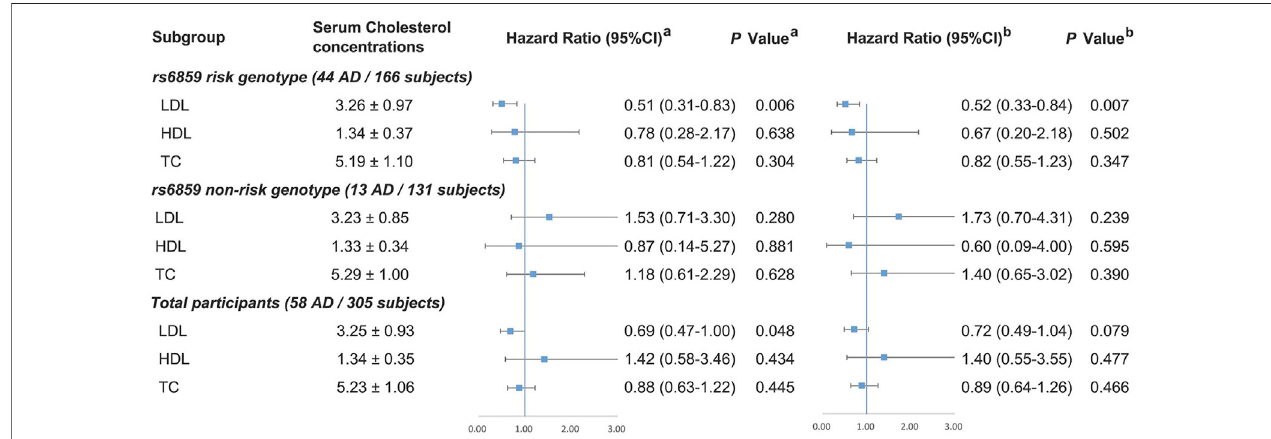
FIGURE 2 | Association between cholesterol and MCI-AD progression among total participants and in subgroups strati fi ed by PVRL2 rs6859 genotypes. PVRL2 rs6859 AG/AA was de fi ned as risk genotype and GG was non-risk genotype. a Model 1 was adjusted for age, gender, APOE ε 4 status, and education years. b Model 2 was additionally adjusted for vascular risk factors (body mass index, diabetes mellitus, hypertension, coronary heart disease, stroke, smoking, and drinking) and lipid- lowering medication. APOE , Apolipoprotein E; TC, total cholesterol; HDL-C, high-density lipoprotein cholesterol; LDL-C, low-density lipoprotein cholesterol. Note: There were eight missing data of genotyping failing for PVRL2